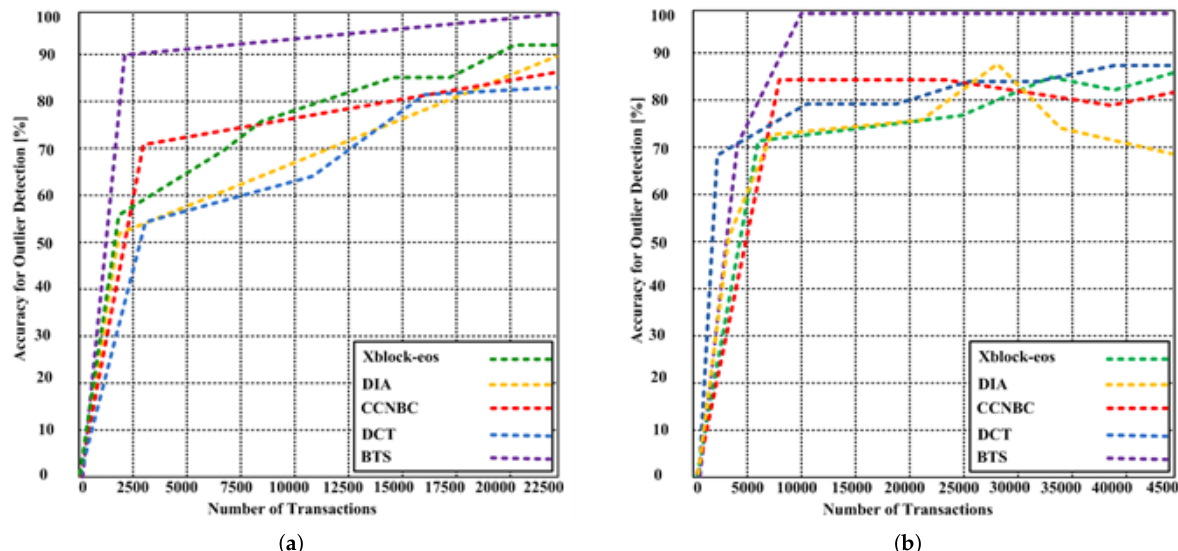
Figure 6. ( a ) The outlier detection accuracy of the proposed BTS and contending methods with the maximum 22,500 transactions; ( b ) The outlier detection accuracy of the proposed BTS and contending methods with the maximum 45,000